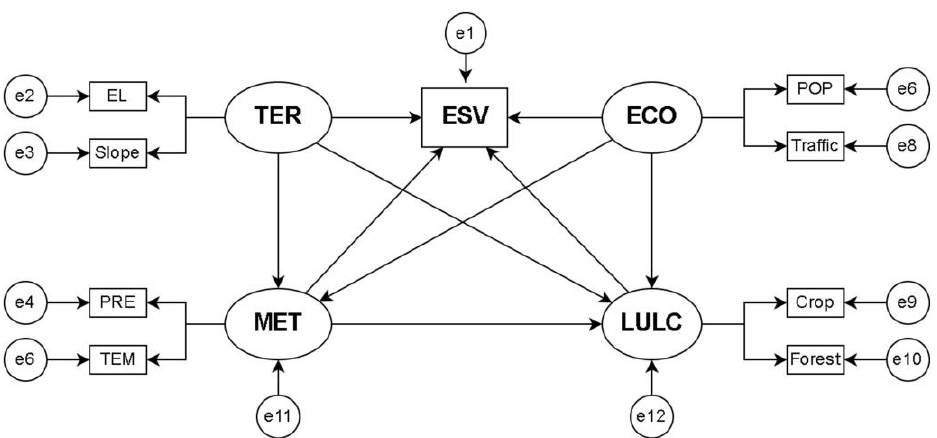
Figure 3. SEM theoretical model. (EL means elevation, PRE means precipitation, TEM means tem- perature, POP means population density, Traffic means the distance to the highway, e1 – e12 mean error of measurement. Thereinto, the higher population density and the closer distance to the high- way represent the higher level of economic development; the higher forest cover and the lower cropland rate represent the better quality of LULC. To ensure the internal consistency of the meas- ured indicators under the latent variables, the corresponding reverse processing of Traffic and Crop was carried out).